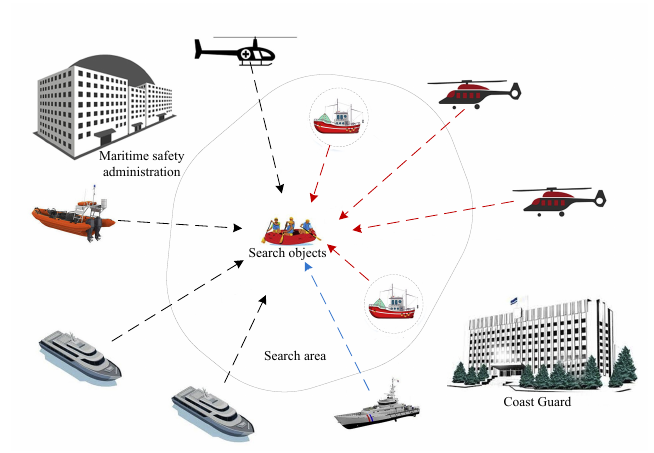
Figure 23. Search and rescue in a maritime emergency.